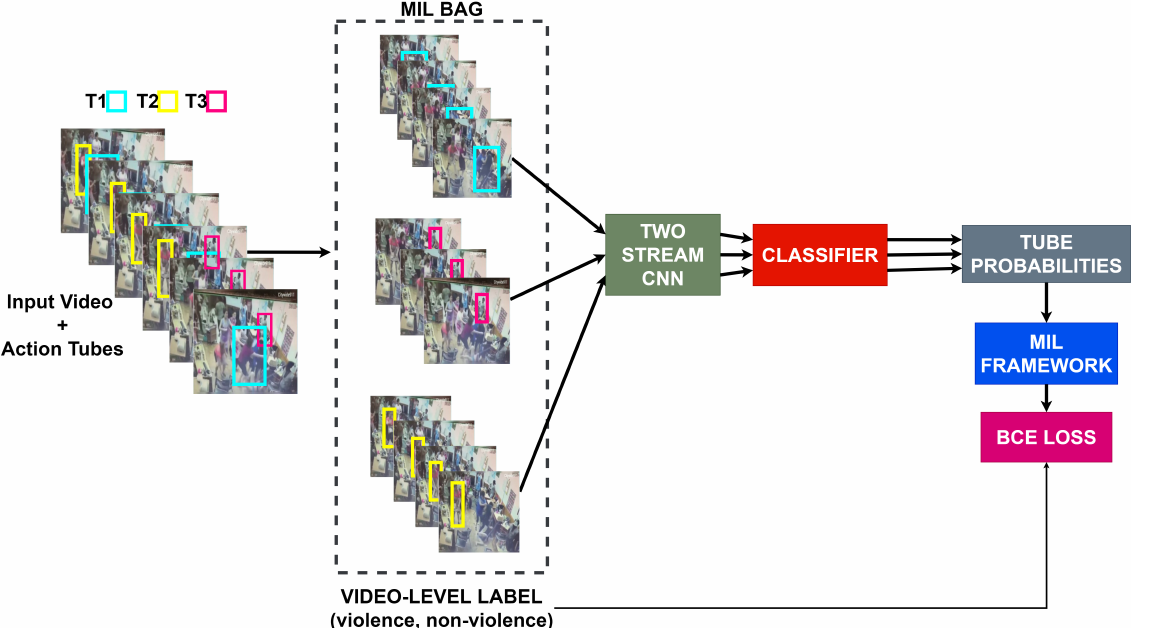
Figure 7. An overview of our approach to training a spatiotemporal violence detector in a weakly supervised manner using an MIL framework. Each bag consists of all tubes ( T 1, T 2 and T 3) generated in previous steps. The two-stream model has the same architecture as that presented in Section 3.2. The classifier outputs are passed through a Sigmoid function to obtain tube probabilities. These probabilities are then aggregated by the MIL framework and compared to the bag-level labels during